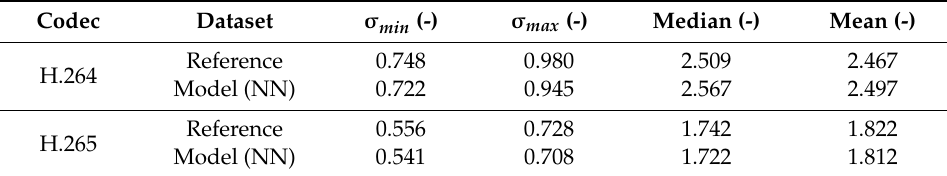
Table 1. Results of exploratory statistical parameters.